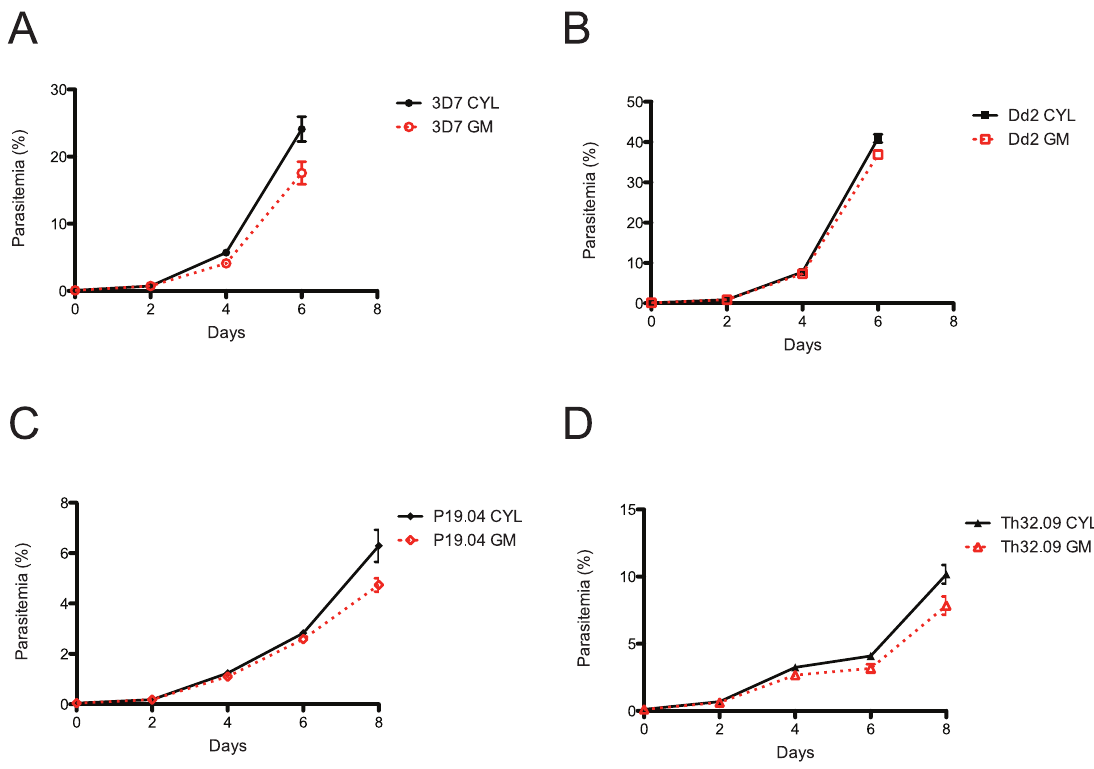
Figure 3. Quantitative 4-cycle growth assays. A & B. Laboratory adapted isolate 4-cycle growth rate comparisons: A. 3D7 and B. Dd2. C & D. Short-term adapted Senegalese isolate 4-cycle growth rate comparisons: C. P19.04 and D. Th32.09. Results from individual experiments are shown, conducted in triplicate, with error bars representing standard error.